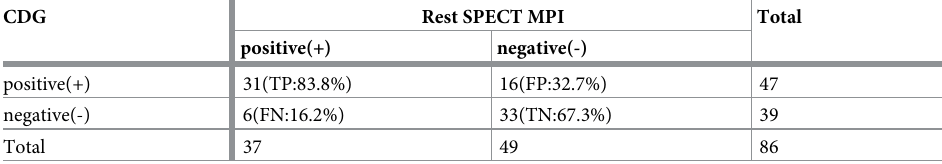
Table 2. Correlation between CDG and rest SPECT. CDG Rest SPECT MPI Total positive(+) negative(-) positive(+) 31(TP:83.8%) 16(FP:32.7%) 47 negative(-) 6(FN:16.2%) 33(TN:67.3%) 39 Total 37 49 86 Accuracy = 74.4%; Sensitivity = 83.8%; Specificity = 67.3%; Kappa value = 0.494; Positive predictive values (PPV) = 66.0%; Negative predictive values (NPV) = 84.6%; Positive likelihood ratio (LR+) = 2.56; Negative likelihood ratio (LR-) = 0.24.